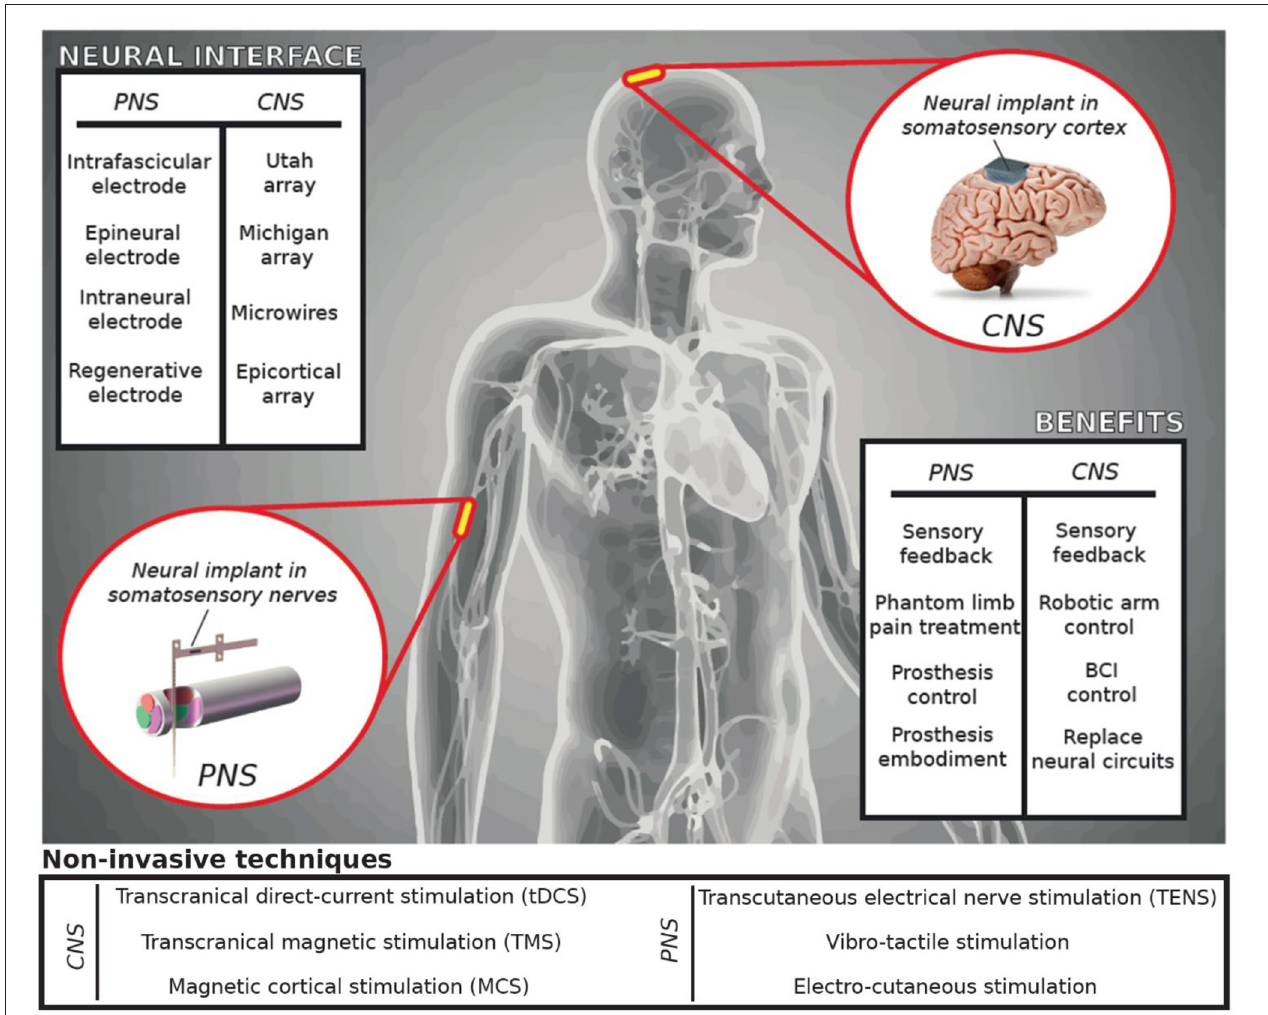
FIGURE 1 | Neuroprosthetic applications. Neurotechnologies for restoring somatosensations have been developed for peripheral (PNS) or central nervous systems (CNS). The stimulation technique used to restore sensory feedback can be invasive (surgically implanted and in intimate contact with the nervous tissue) or non-invasive (applied on the skin surface). Delivering a stimulation to the brain or peripheral nerves provides benefits such as the control of robotics, smart prosthetics, or other assistive